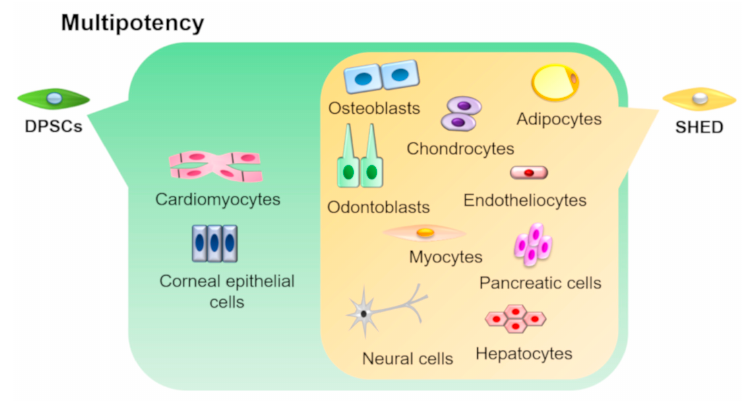
Figure 3. Multipotency of DPSCs and SHEDs. DPSCs and SHEDs can di ff erentiate into multiple lineages such as osteoblasts, odontoblasts, adipocytes, chondrocytes, neural cells, endotheliocytes, myocytes, hepatocytes, and pancreatic cells under appropriate culture conditions. In addition, DPSCs can also di ff erentiate into corneal epithelial cells and cardiomyocytes.